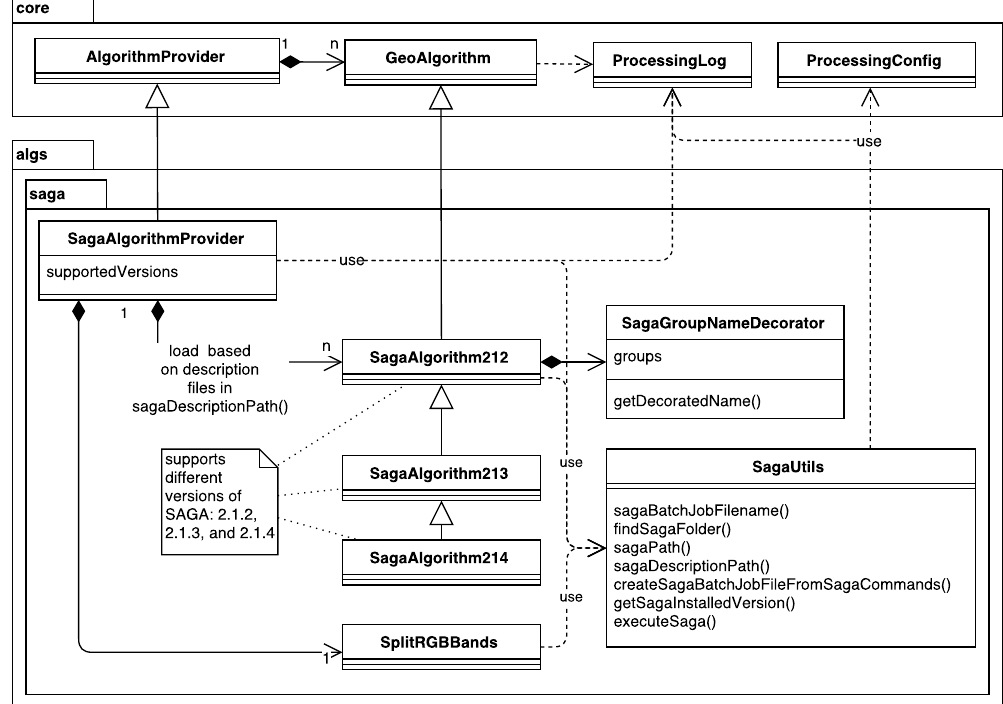
Figure 11. Class diagram of the saga package and its connections to other